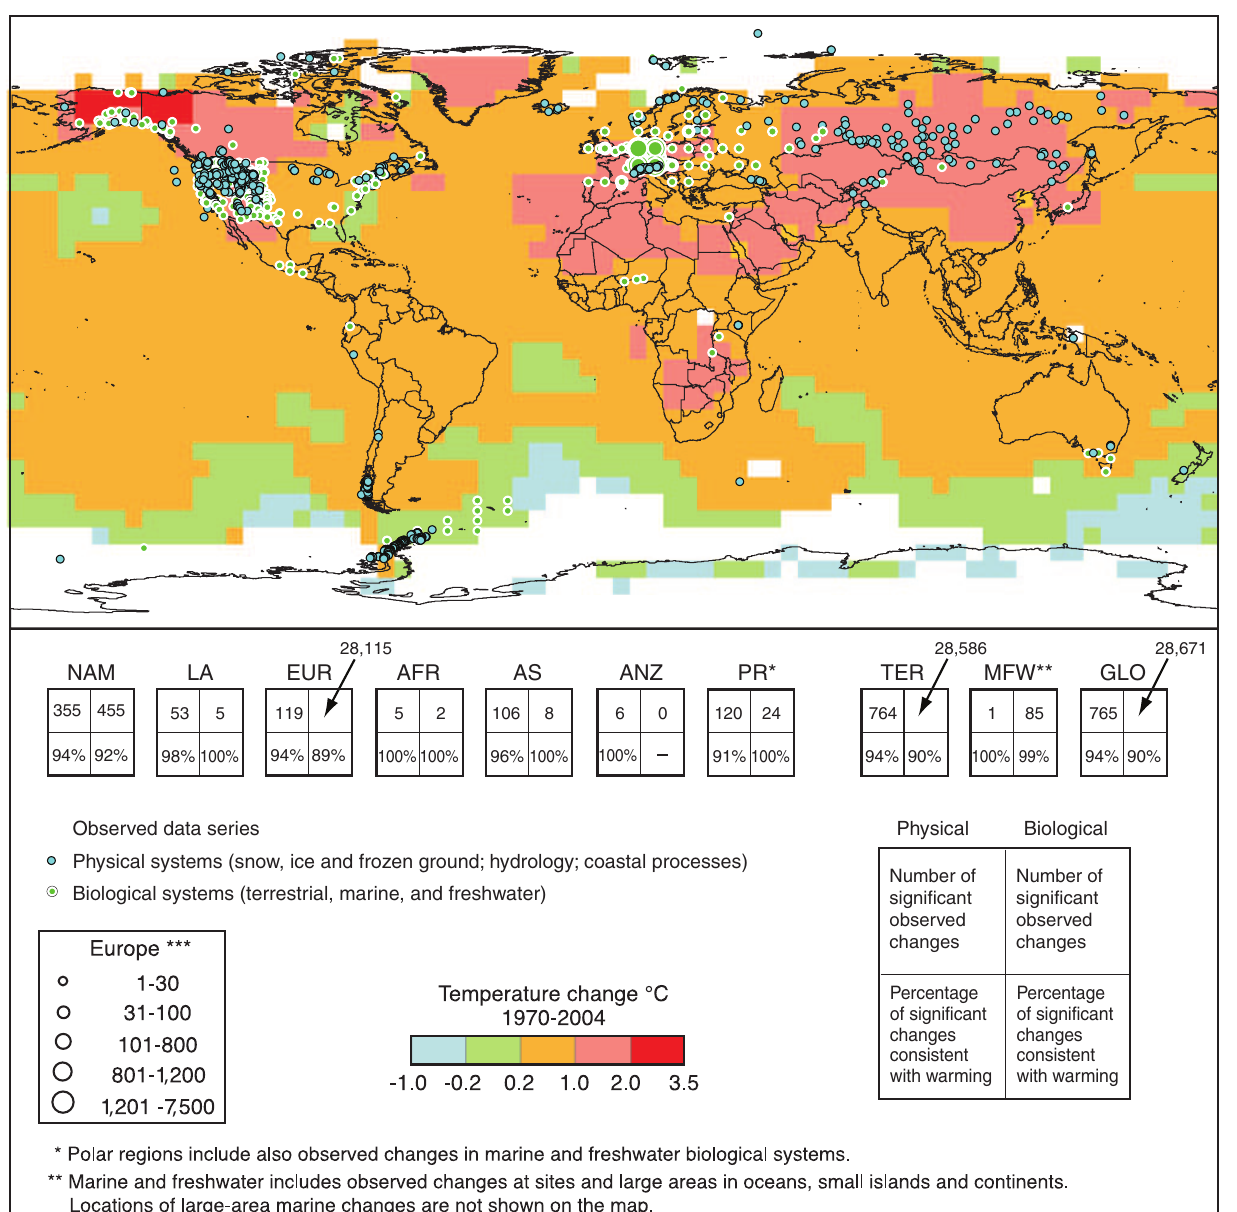
Figure SPM.2. Locations of significant changes in data series of physical systems (snow, ice and frozen ground; hydrology; and coastal pro- cesses) and biological systems (terrestrial, marine and freshwater biological systems), are shown together with surface air temperature changes over the period 1970-2004. A subset of about 29,000 data series was selected from about 80,000 data series from 577 studies. These met the following criteria: (1) ending in 1990 or later; (2) spanning a period of at least 20 years; and (3) showing a significant change in either direction, as assessed in individual studies. These data series are from about 75 studies (of which about 70 are new since the TAR) and contain about 29,000 data series, of which about 28,000 are from European studies. White areas do not contain sufficient observational climate data to estimate a temperature trend. The 2 × 2 boxes show the total number of data series with significant changes (top row) and the percentage of those consistent with warming (bottom row) for (i) continental regions: North America (NAM), Latin America (LA), Europe (EUR), Africa (AFR), Asia (AS), Australia and New Zealand (ANZ), and Polar Regions (PR) and (ii) global-scale: Terrestrial (TER), Marine and Freshwater (MFW), and Global (GLO). The numbers of studies from the seven regional boxes (NAM, EUR, AFR, AS, ANZ, PR) do not add up to the global (GLO) totals because numbers from regions except Polar do not include the numbers related to Marine and Freshwater (MFW) systems. Locations of large- area marine changes are not shown on the map. {Figure